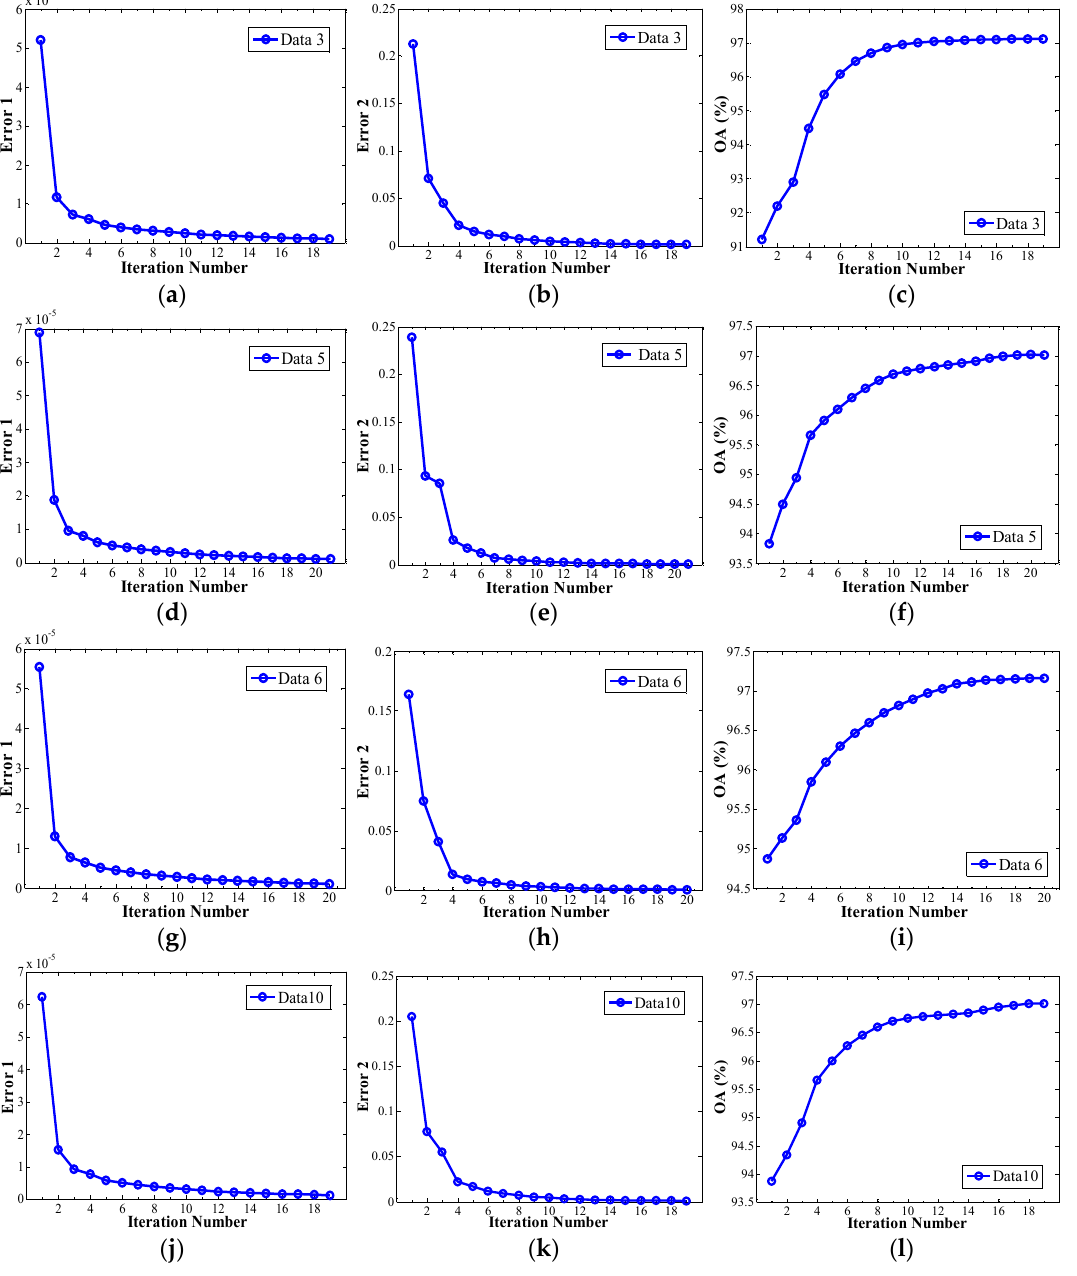
Figure 10. Performance curves of LRSD_SS: ( a ) Error 1; ( b ) Error 2; and ( c ) OA in an exemplary case of Data 3; ( d ) Error 1; ( e ) Error 2; and ( f ) OA in an exemplary case of Data 5; ( g ) Error 1; ( h ) Error 2; ( i ) OA in an exemplary case of Data 6; and ( j ) Error 1; ( k ) Error 2; and ( l ) OA in an exemplary case of Data 10. In each graph, the x-axis represents iteration number and the y-axis indicates evaluation criteria. OA is short for overall accuracy.